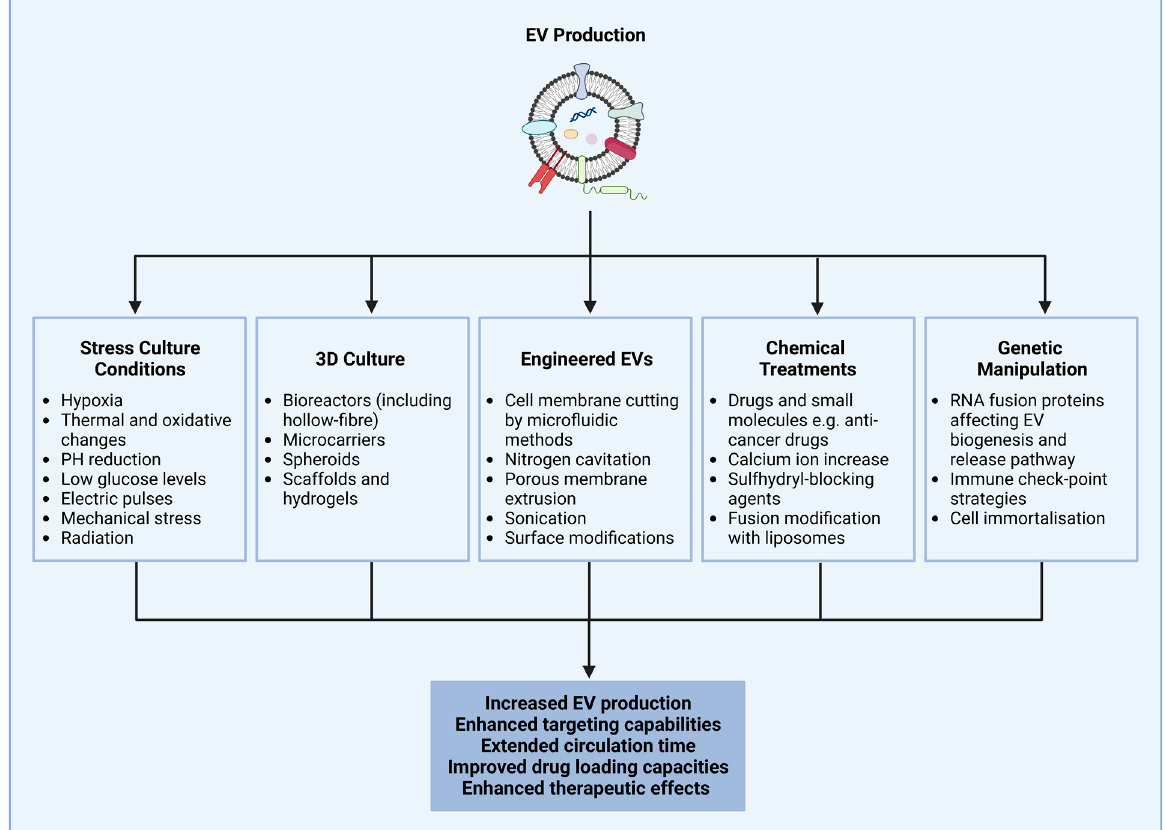
Figure 2. Strategies for enhancing extracellular vesicle production.